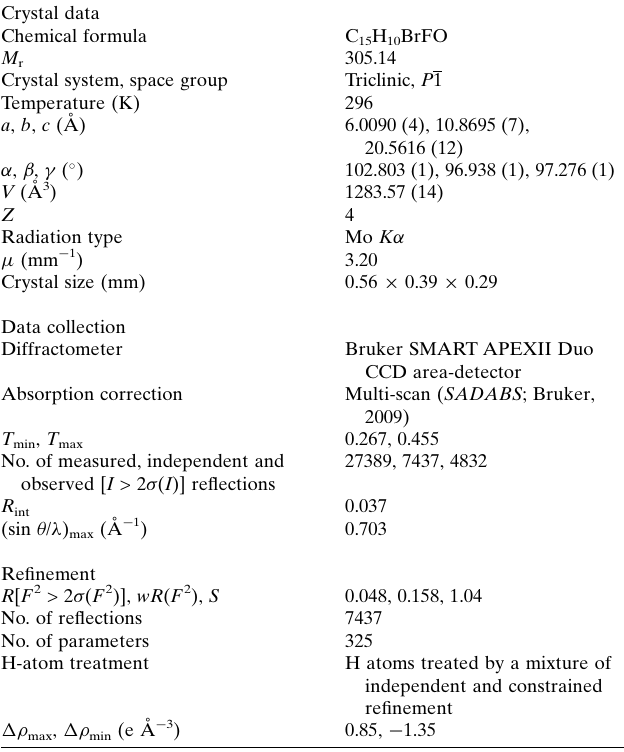
Table 2 Experimental details. Crystal data Chemical